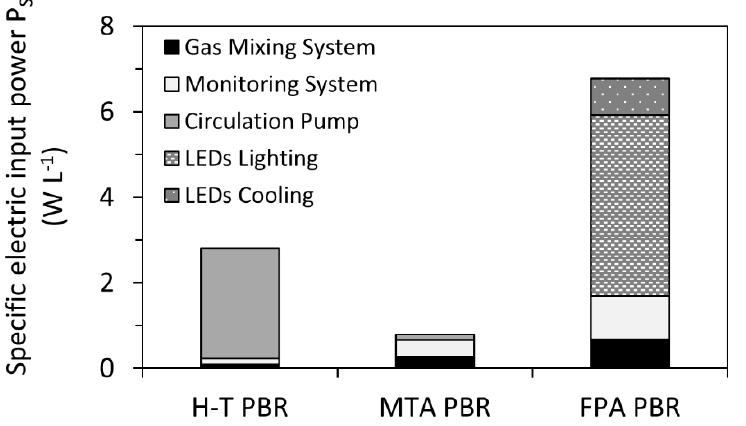
Figure 6. Specific electric input power P S (W L − 1 ) as measured for H-T PBR, MTA PBR, and FPA PBR. Distribution of individual components within each PBR is summarized in Equations (6)–(8). Note that the circulation pump was not part of FPA PBR and, on the contrary, LEDs lighting and cooling were specific for FPA only.